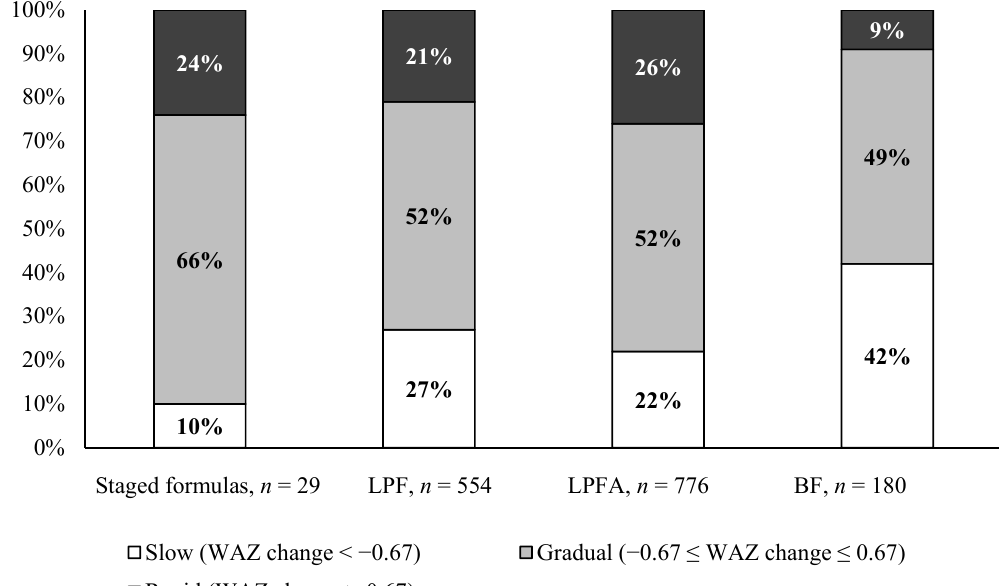
Figure 3. Weight gain pattern between birth and four months of age.Data are presented as the percentage of infants in weight gain categories based on WAZ change as slow (< − 0.67), gradual ( − 0.67 to 0.67), or rapid (>0.67), for infants fed staged formulas in the current study, and infants included in a pooled analysis [18] who were fed lower protein formula (LPF, 1.8 g protein/100 kcal) or lower protein formula with active ingredients (LPFA, 1.8 g protein/100 kcal with prebiotics, probiotics, or both), or breastfed infants (BF). WAZ change was calculated using WAZ at four months of age, minus WAZ at birth. Graphs for LPF, LPFA, and BF were created, based on the data published in Alexander et al. [18], after obtaining the journal’s permission.